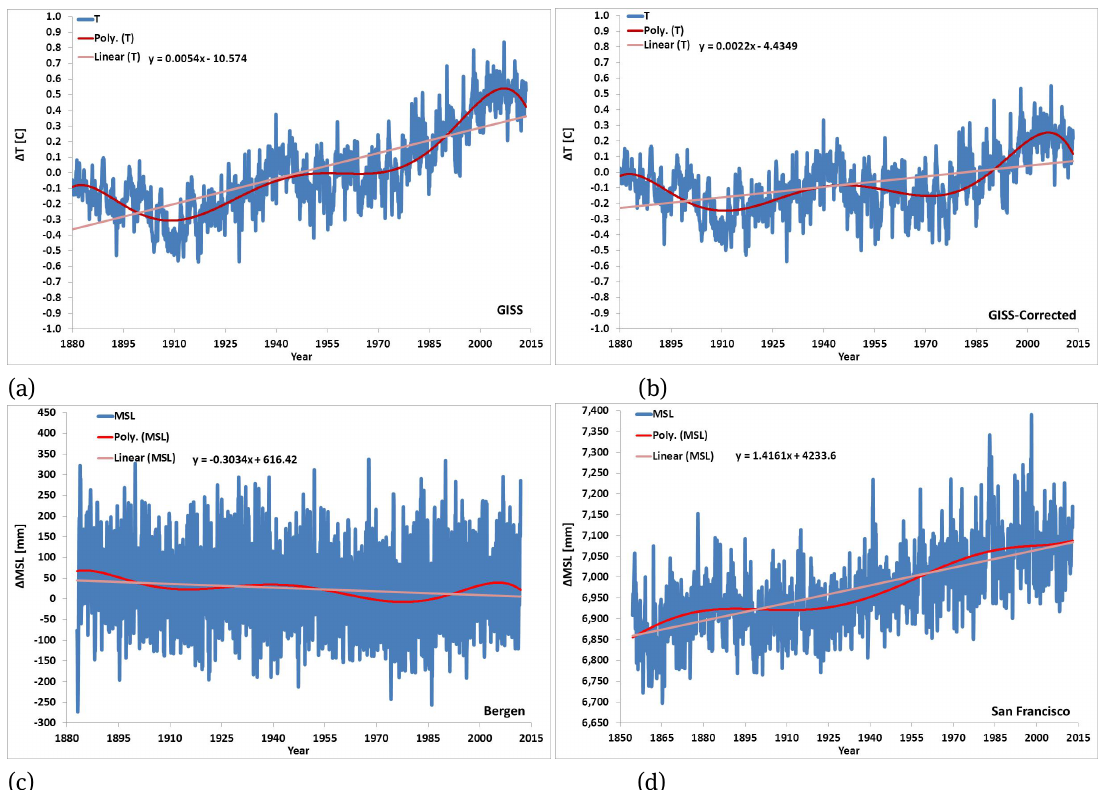
Fig. 2. Top: Global land and sea surface temperatures uncorrected (from [9]) and corrected to account for some upwards biases and inaccu- racies (as described in [10, 11]); Bottom: Relative (sea-to-land) sea level from the San Francisco and Bergen tide gauges (data from [14]). San Francisco is certainly subject to subsidy and Bergen to isostasy, but the vertical velocity of the tide gauge datum is not known with same accuracy of the relative sea level velocity. The land velocity of the GPS station nearby the San Francisco tide gauge is − 1.12 mm/year [15]. This reduces the absolute sea level rise to about 0.3 mm/year. For Bergen, the small apparent land uplifts for the area [16] suggests a sim- ilarly close to zero absolute rates of rise of sea levels. The relative sea level oscillates about a constant rate of rise with many periodicities detected up to the clear quasi 60 years. The land and sea surface temperatures oscillate with about the same periodicities. The world deep ocean temperatures and salinity are not known with accuracy prior of the start of the ARGO project in the early 2000, but have not changed 60 S to 60 N over this time window [6, 7]. Over same time window the South and North Pole temperatures and sea ice extent have also been stable [17,